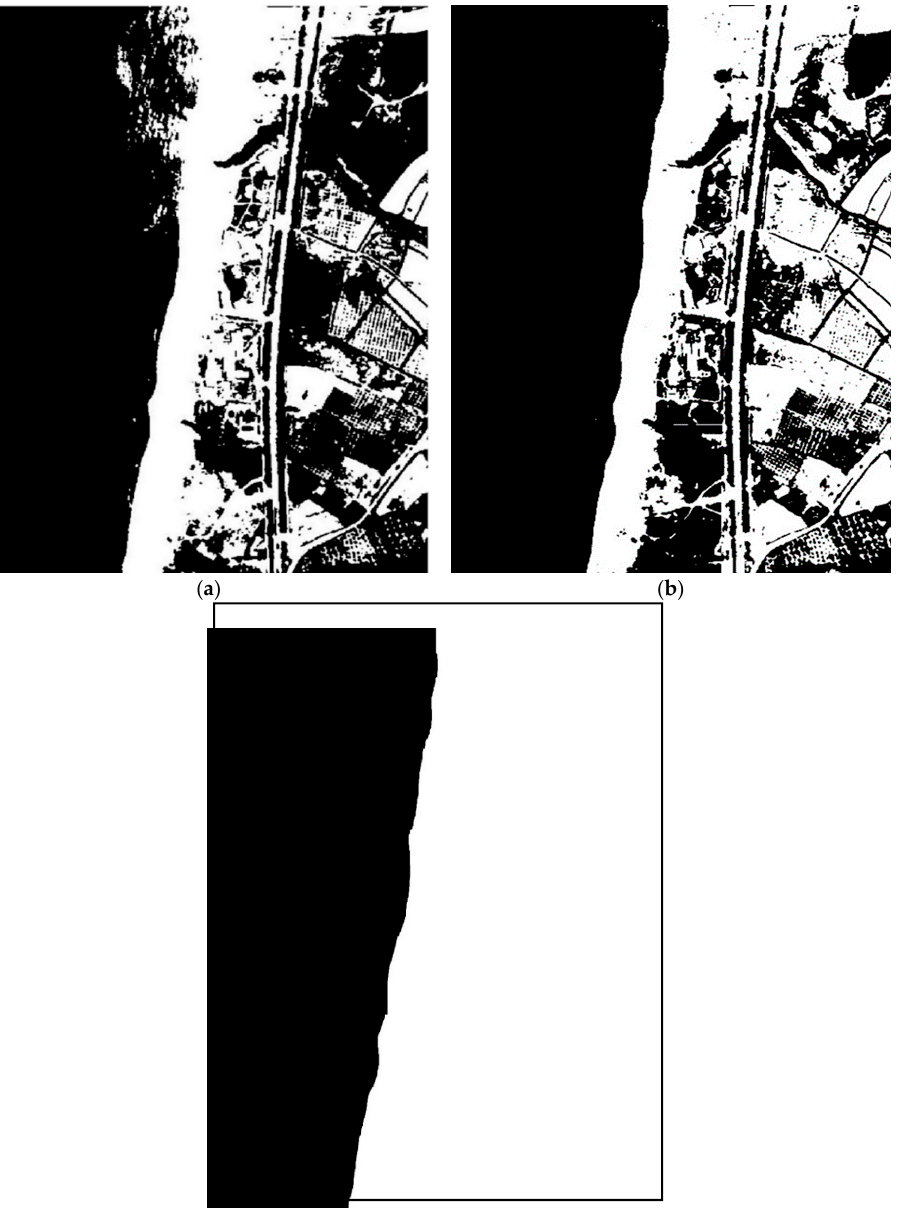
Figure 7. ( a ) k-means clustering, ( b ) segmented image, and ( c ) region grouping and removal of small objects.